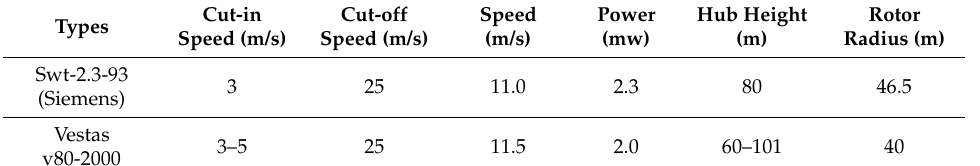
Table 5. Main parameters of the wind turbine installed in R φ nland , Denmark.